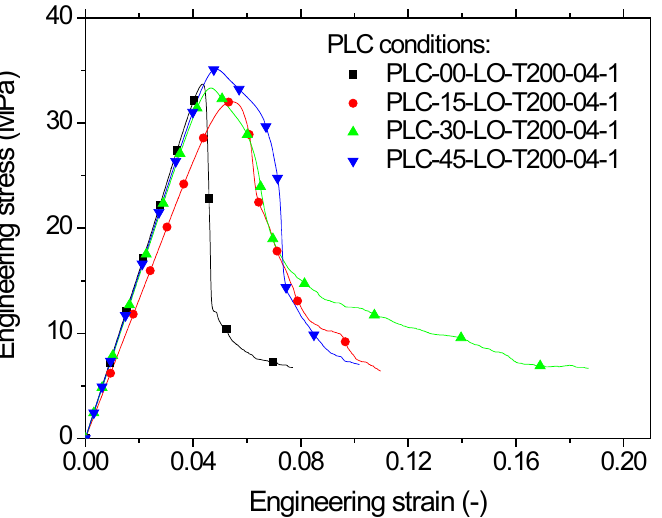
Figure 13. Tensile response of PLC printed using horizontal orientation (LO) for various printing angles, ranging from 0 to 45°.